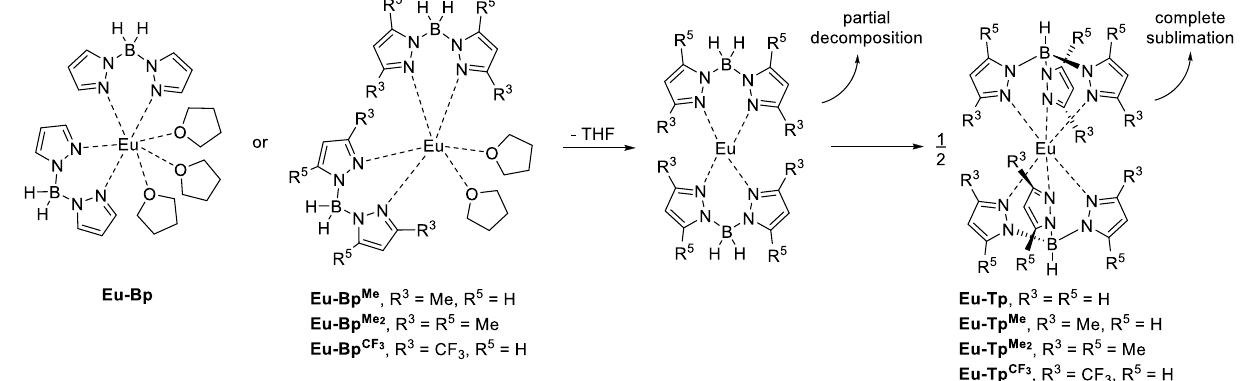
Figure 4. Thermogravimetric curves and derivative thermogravimetric curves of the four Eu(II) complexes: ( a ) Eu-Bp; ( b ) Eu-Bp Me ; ( c ) Eu-Bp Me2 ; ( d ) Eu-Bp CF3 .